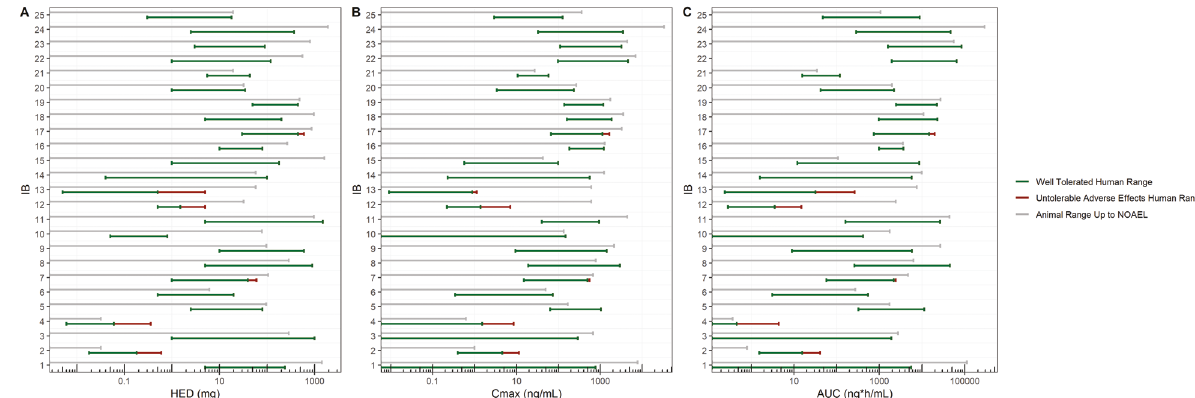
Fig. 3 Safe and tolerable dose ranges. A The overlap ranges for HED are depicted. B The overlap ranges for C max are depicted. C The overlap ranges for AUC are depicted. For both preclinical (animal) and clinical (human) studies the investigated ranges per pharmacokinetic parameter are depicted. The preclinical (animal) ranges are depicted in grey. The clinically (human) well-tolerated ranges are in green and the ranges that were well-tolerated preclinically, but not clinically are depicted in